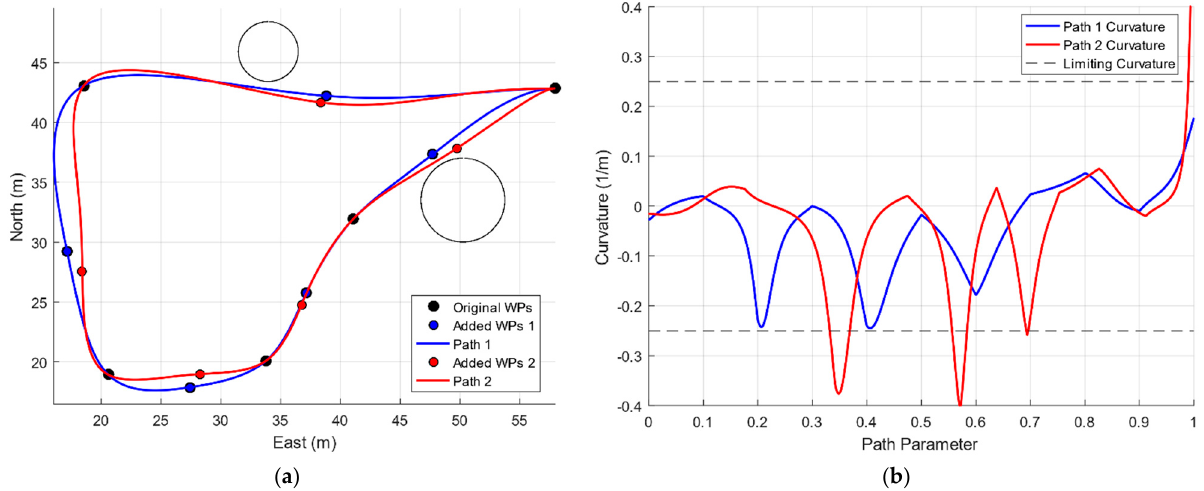
Figure 10. Simulated result of path planner: path that meets (blue) and does not (red) meet the limiting curvature are shown in ( a ); their corresponding curvature plots in ( b ).